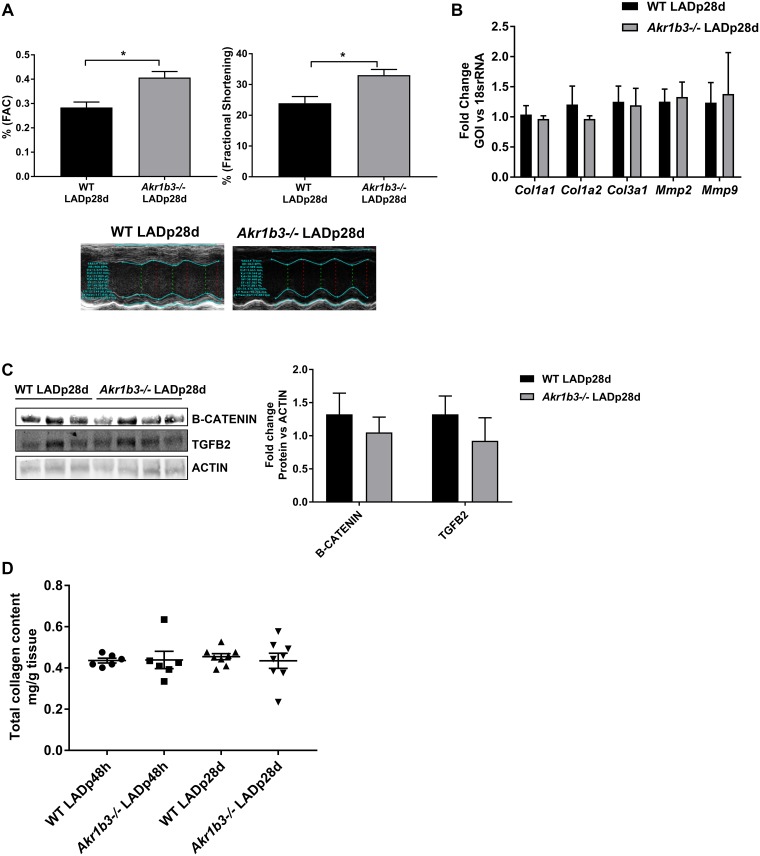
Absence of changes in expression of fibrotic factors in Akr1b3 null I/R mice hearts after 28 days of recovery.Mice were subjected to LAD and studies were done 28 days post infarction recovery. (A) Echocardiographic measurements made in WT and Akr1b3 null mice. Functional measurements, fractional shortening (FS) and fractional area change (FAC) are expressed as %, with representative image, N = 10 mice/group. (B) qRT-PCR on collagens (Col1a1, Col1a2, Col3a1) and MMPs (Mmp2 and Mmp9) from heart tissue, N = 5 mice/group. (C) Western blot from heart lysates for detection of β-catenin and TGFB2 normalized to Beta-Actin, N = 4 mice/group. (D) Total collagen levels in hearts from mice subjected to LAD post 48 h and 28 days of recovery, N = 4 mice/group. Error bars represent mean ± SEM. * p<0.05, unless otherwise noted.